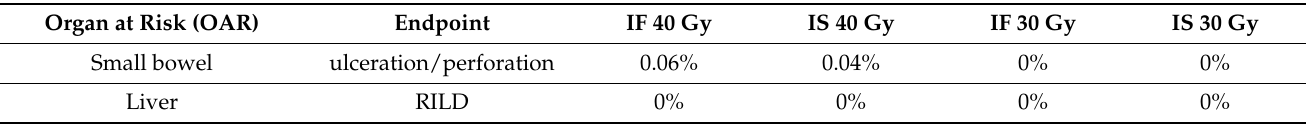
Table 5. Estimated high-grade